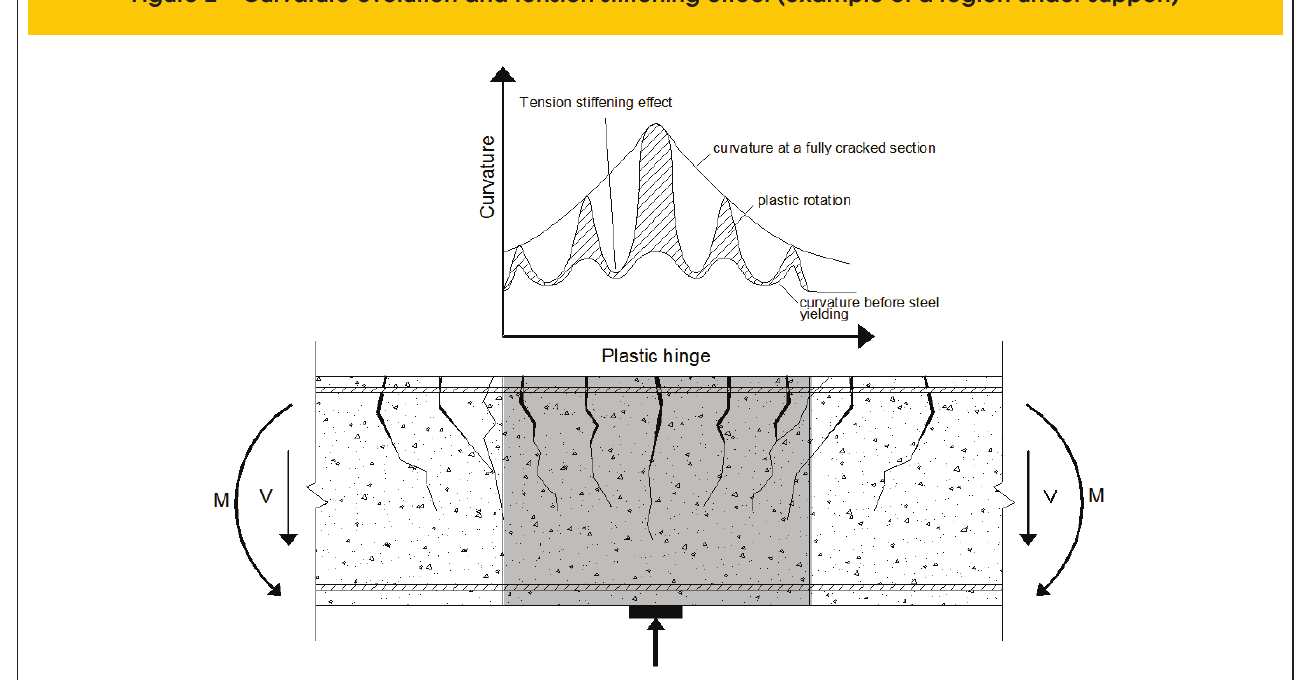
Figure 2 – Curvature evolution and tension stiffening effect (example of a region under